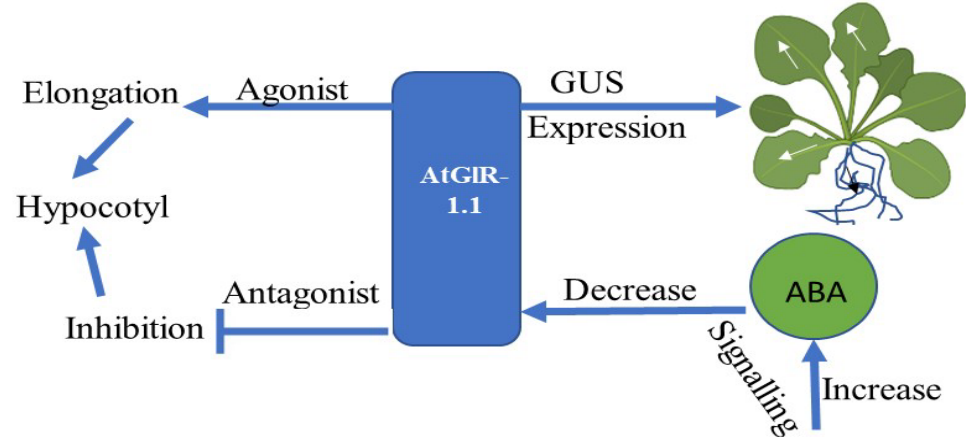
Figure 5. Flowchart showing the expression and function of the AtGluR-1.1 gene.